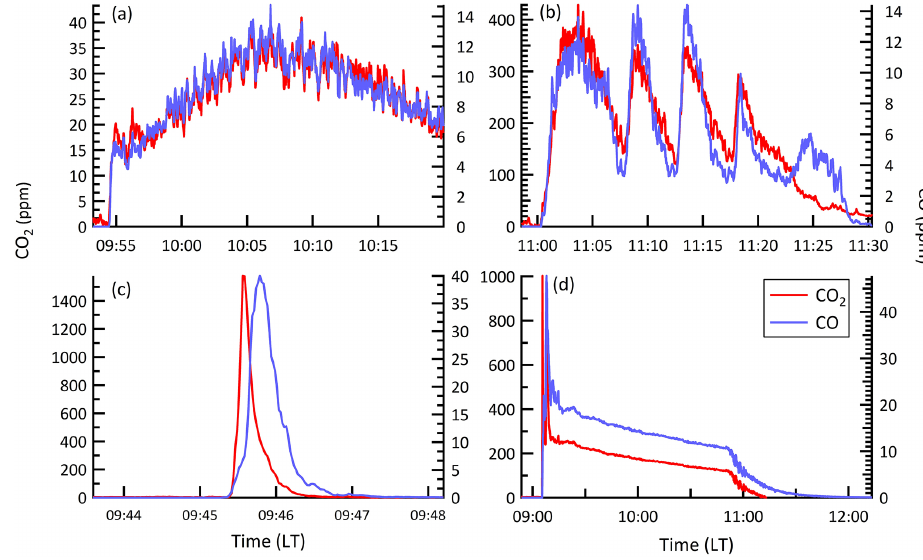
Figure 1. (a) Typical peat “stack” burn, (b) open cookstove stack burn (feeding fire), (c) grass stack burn, and (d) “room”